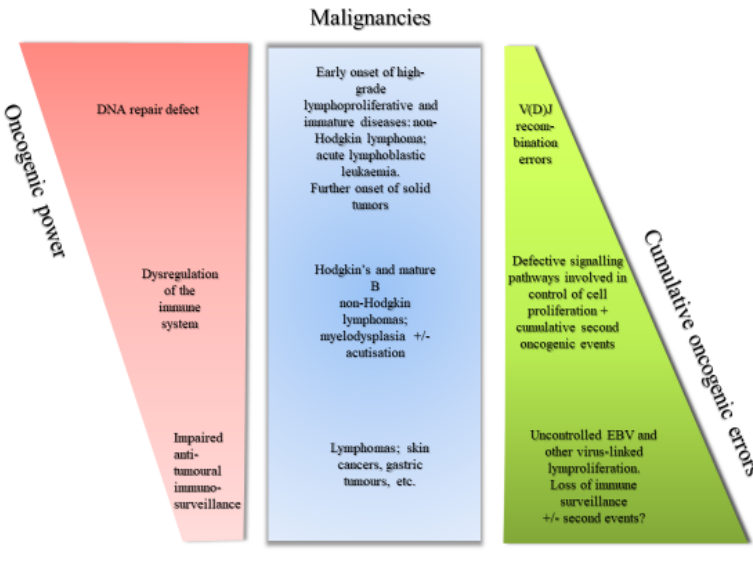
Figure 1. Illustrates oncogenic mechanisms of cancers with underlying Figure 1. illustrates oncogenic mechanisms of cancers with underlying PID.